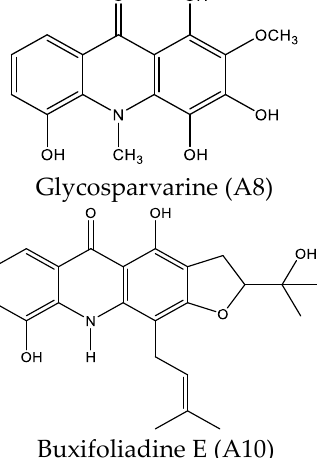
Figure 1. Structures of acridone alkaloids.